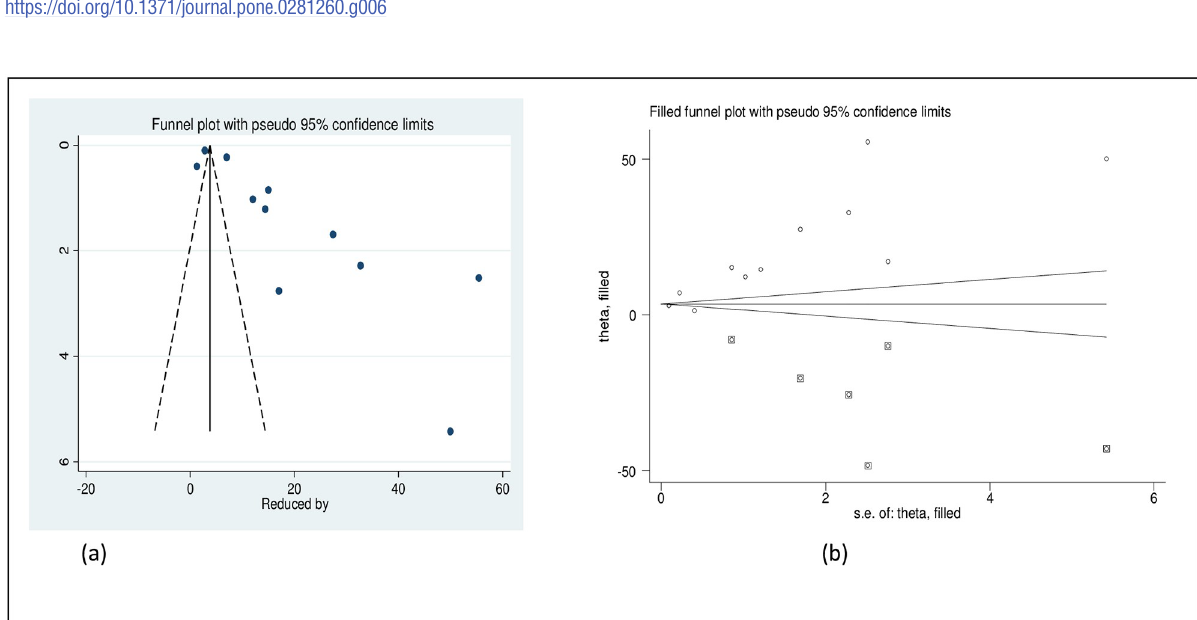
Fig 7. Original funnel plot (a) and filled funnel plot (b) of all included studies.